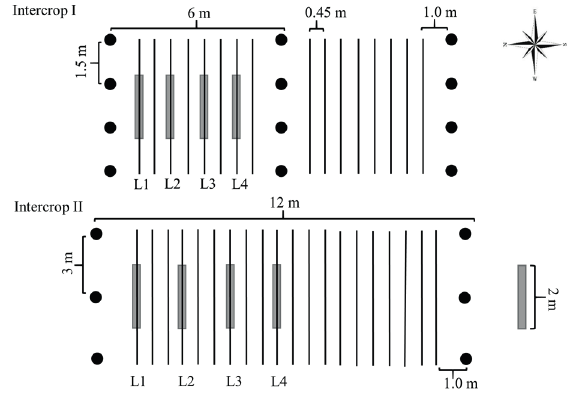
Figure 1 - A sketch of an experimental unit of the agroforestry systems (Intercrop I and Intercrop II), conducted in the agricultural years 2013/2014 and 2014/2015. Black circles represent the trees; continuous lines indicate where the soybean was sown, and the rectangles in gray represent the evaluation plots of soybean. Southern,